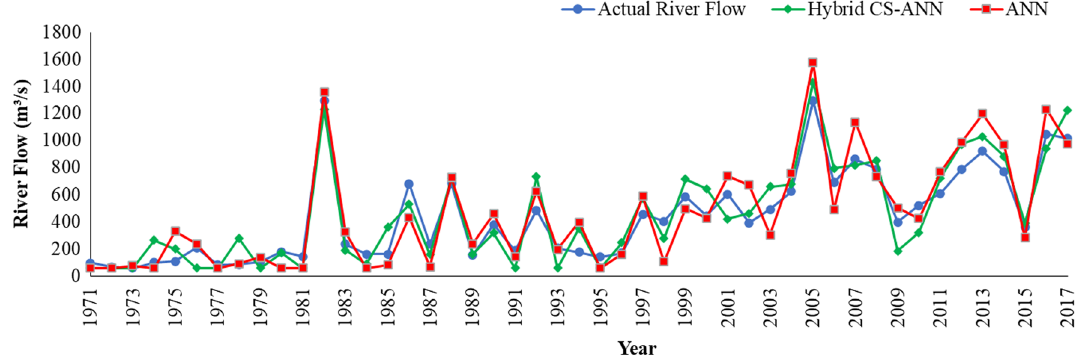
Fig. 4 Comparison between Stand-alone ANN and Hybrid CS-ANN